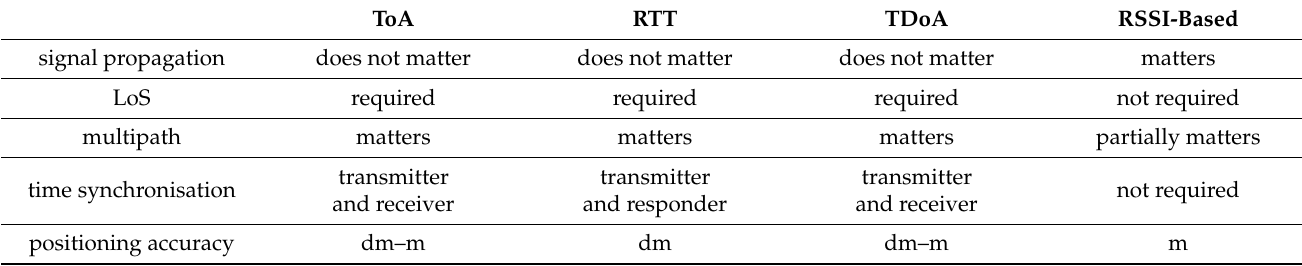
Table 3. Characteristics and properties of range-based localization techniques for